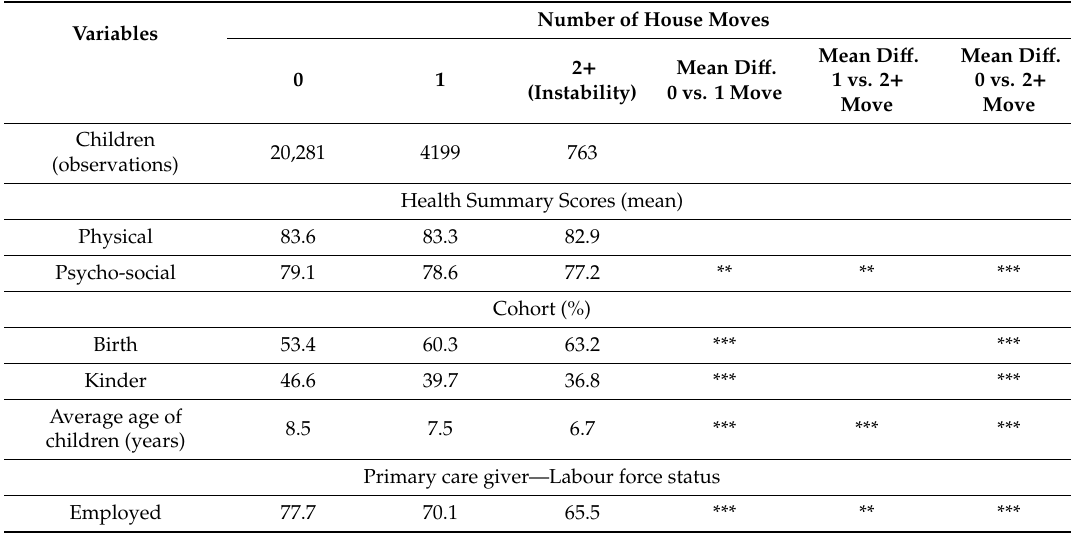
Table 1. Summary statistics of selected groups of 0, 1 and 2 +